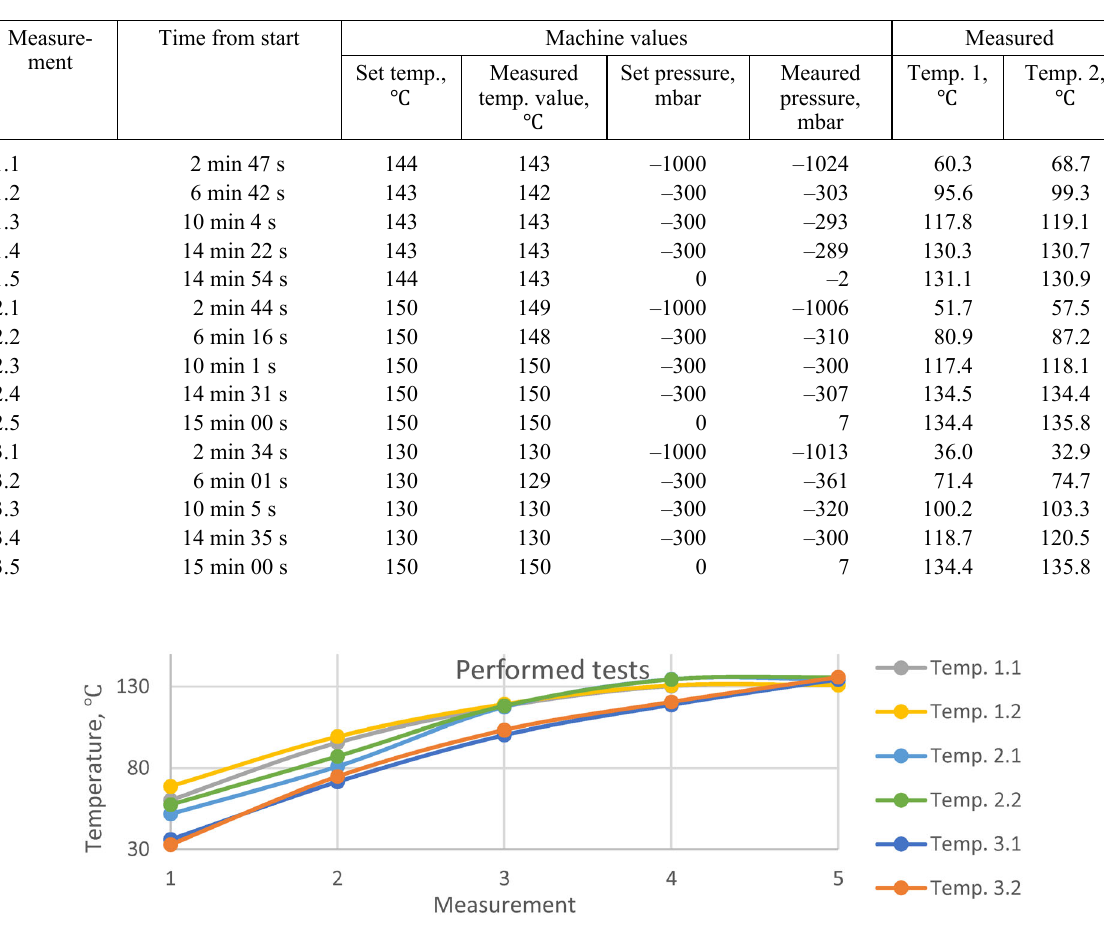
Table 2. Results of the tests